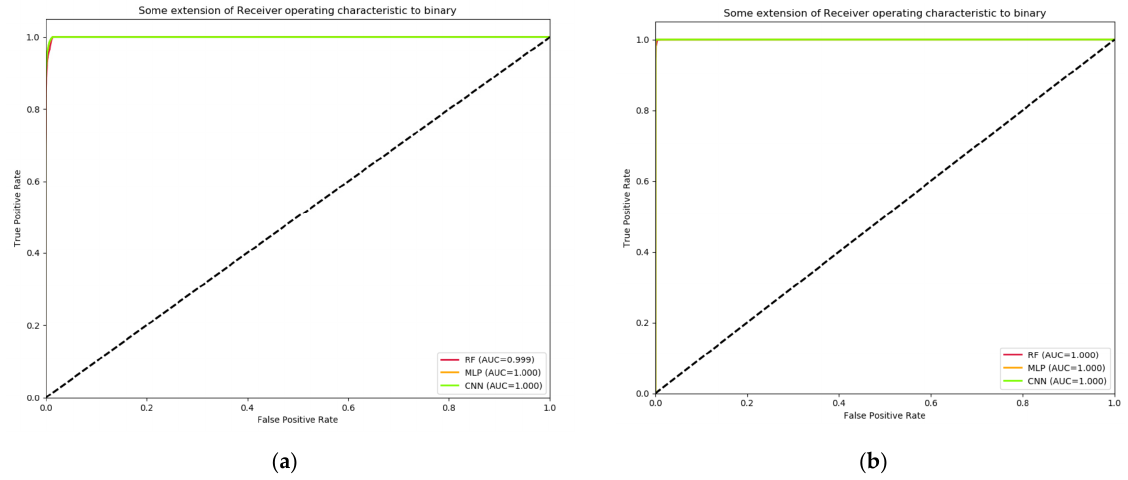
Figure 3. ROC curve of binary classification. ( a ) ROC curve for UNSW-NB15; ( b ) ROC curve for CICIDS2017.